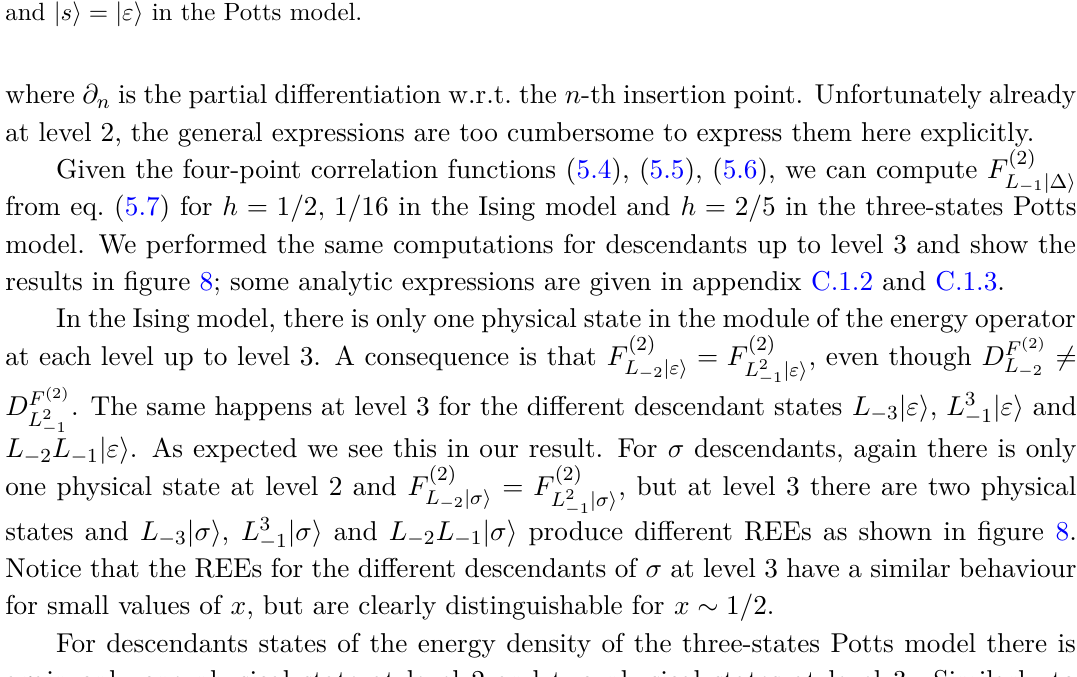
Figure 8 . The correlator F (2) for different descendants of | s i = | ε i and | s i = | σ i in the Ising model | s i and | s i = | ε i in the Potts